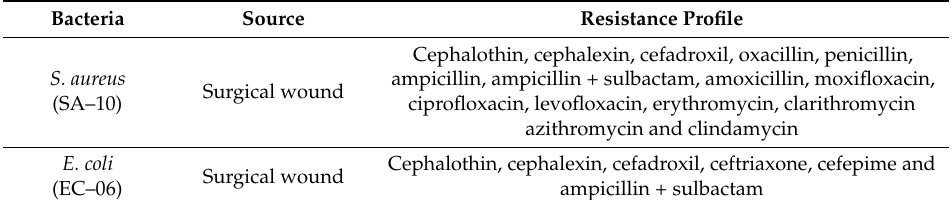
Table 1. Bacterial source and antibiotic resistance